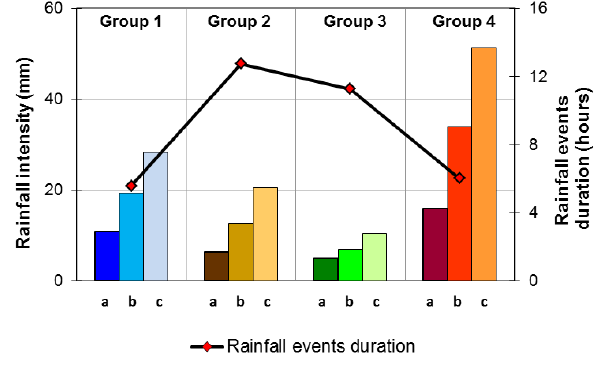
Fig. 4. Rainfall intensities and duration of rainfall events of the different groups. On the x-axis, a: 10-min, b: 30-min and c: 60-min rainfall intensity, for the events of the groups indicated on top of the diagram. Rainfall intensities are reported on the left Y-axis, and duration of the events are indicated on the right